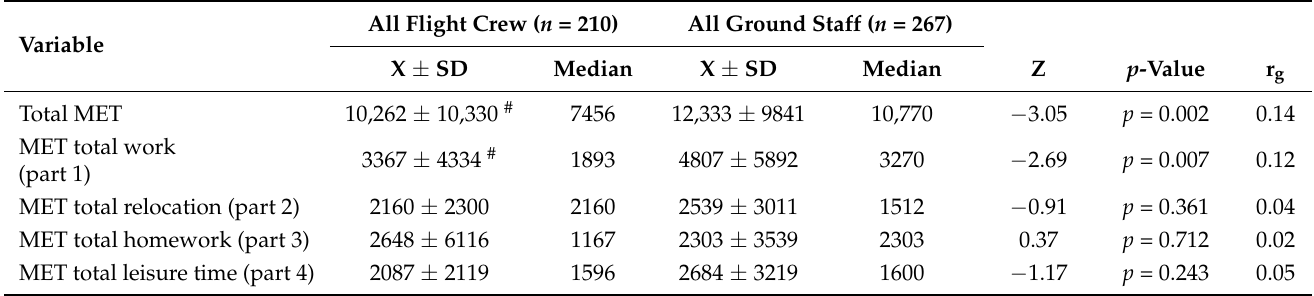
Table 3. Summary of MET values in flight crew and ground staff according to IPAQ criteria.